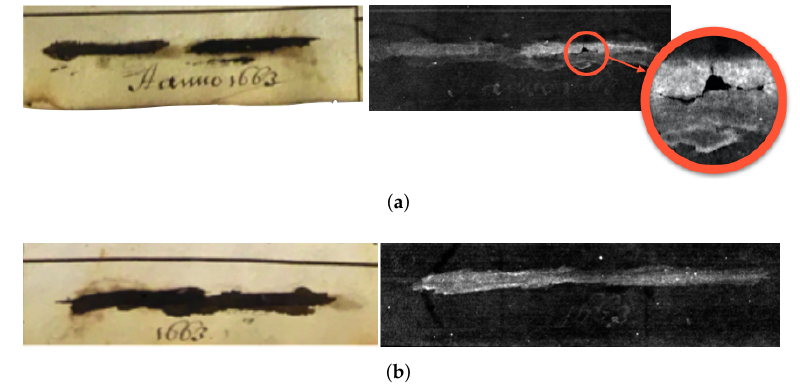
Figure 12. Two examples of the false positives with photographs of the scribblings on the left, and processed radiographs on the right. The top set in ( a ) indicate a partially torn page, and the bottom set in ( b ) show no detectable calligraphy in the post-processed image.